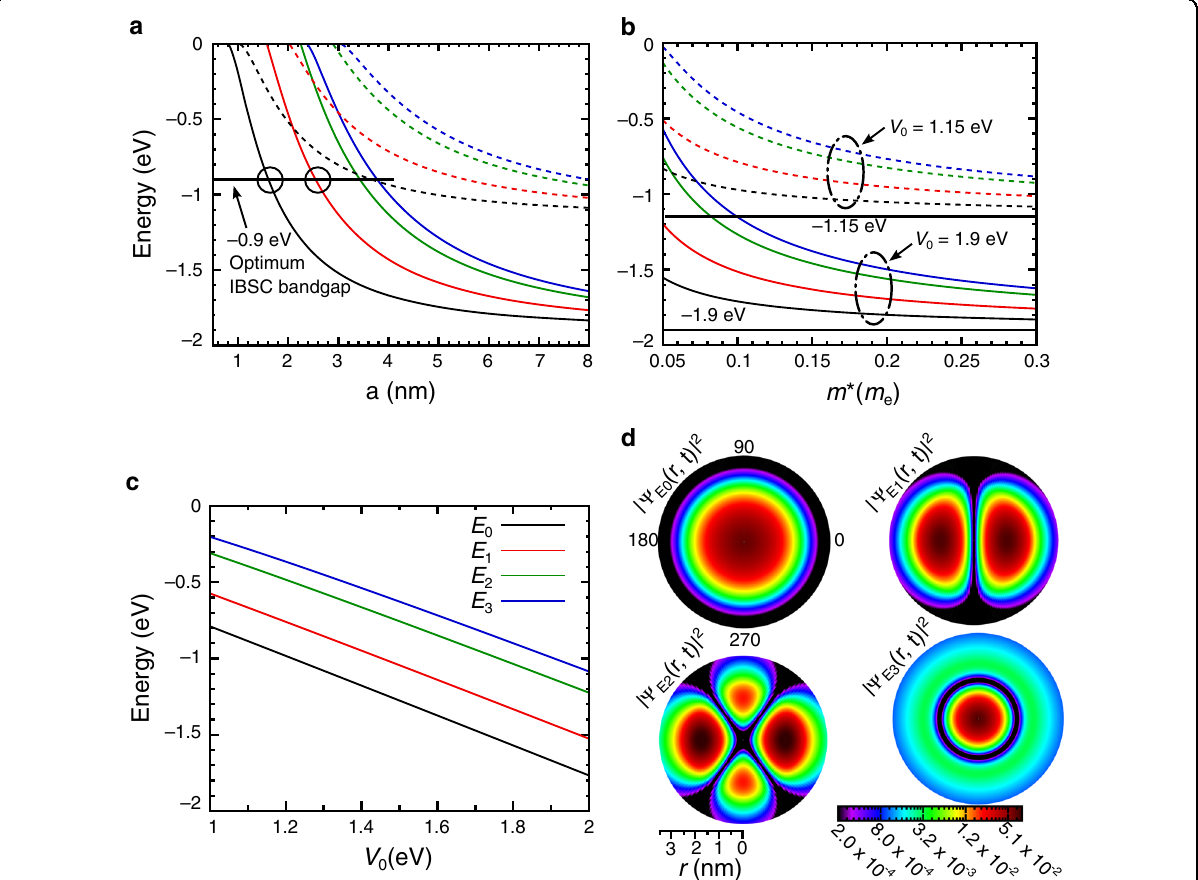
Fig. 2 QD size impact on the fi rst 4 energy levels (labeled from E 0 to E 3 ), the results were obtained with m * of 0.08 m e . a QD size in fl uence on the energy levels for potential barrier of 1.15 and 1.90 eV, dashed and continuous lines, respectively. The horizontal gray line indicates the ideal bandgap for an intermediate-band solar cell and the circles refer to the QD sizes used for the following studies. b QD effective mass in fl uence on the energy levels for potential barrier of 1.15 and 1.90 eV, dashed and continuous lines, respectively. The horizontal gray lines represent the energy levels for − 1.15 and − 1.90 eV. c Effect of the potential barrier between the host and QD material on the energy levels. d Representation of the normalized wavefunctions for the fi rst four energy levels of a 2.5 nm QD with 0.08 m e effective mass and 1.90 eV potential barrier, where the m value of the spherical harmonics was taken to be